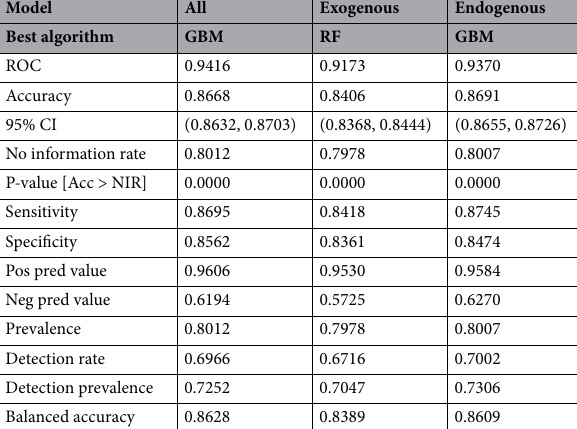
Table 4. Accuracy performance indicators for European universities’ co-publication prediction in Physical and Engineering Sciences. Three models considered: with all, with only exogenous, and with only endogenous